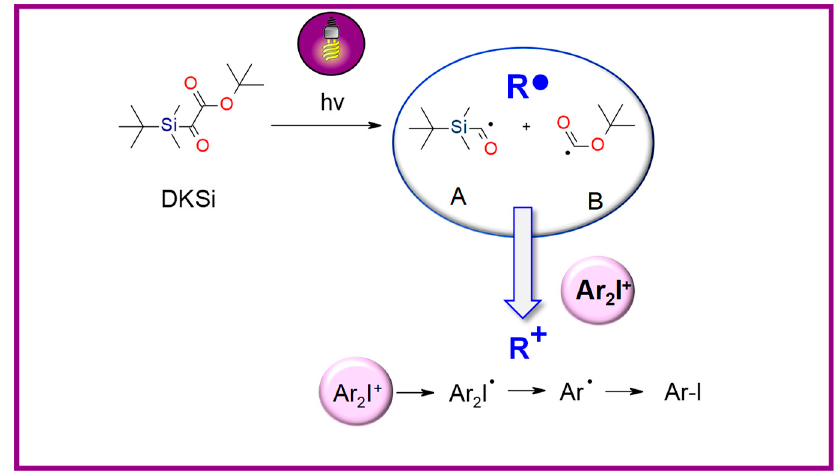
Figure 18. Proposed mechanism of formation cations from the photoinitiating system DKSi/iodonium